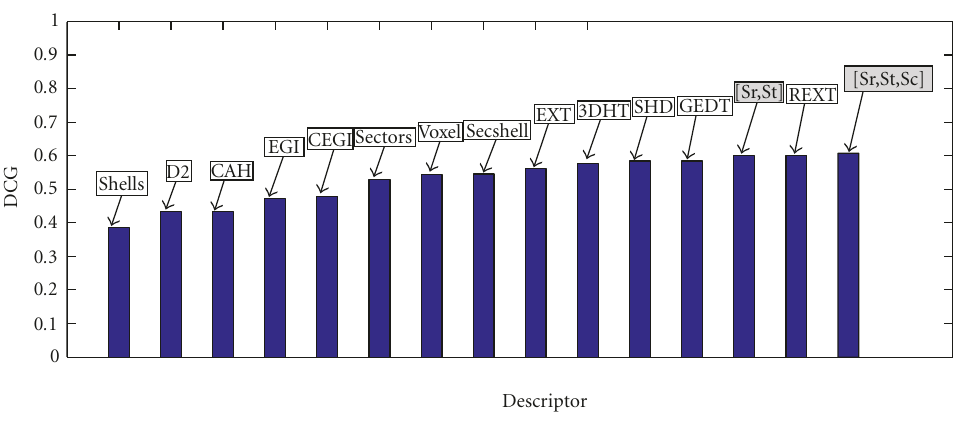
Figure 11: Comparison of 3D shape descriptors on PSB test set. (Except CAH, 3DHT, and our descriptors, DCG values are taken from